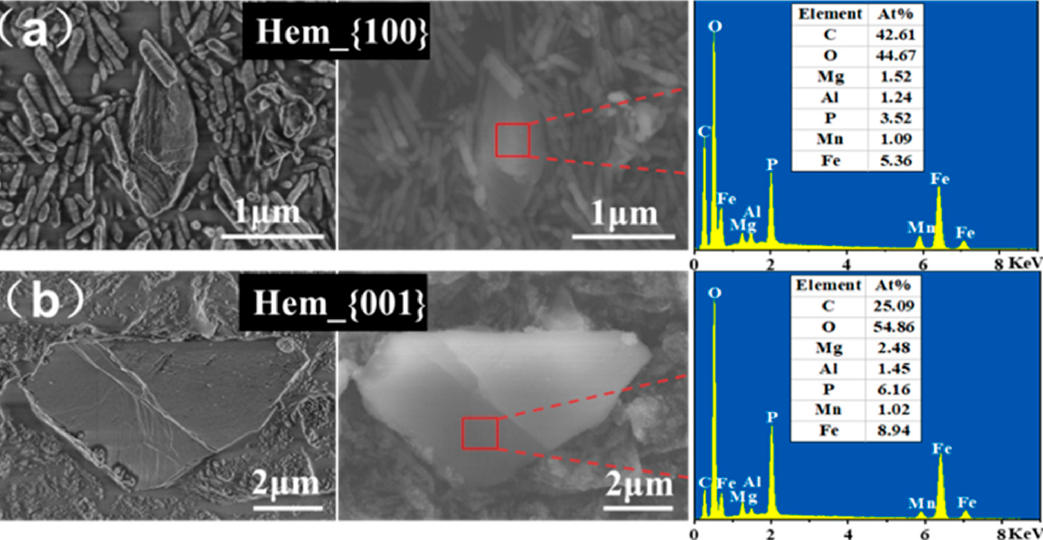
Figure 4. SEM image of vivianite in Hem_{100} ( a ) and Hem_{001} ( b ) systems and the corresponding EDS patterns.